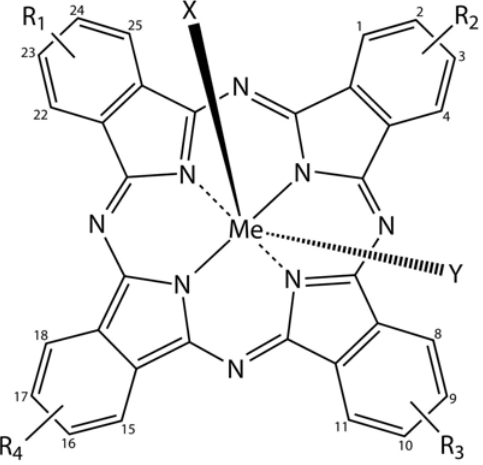
Figure 5. General chemical structure of metal-phthalocyanine dyes. Me denotes the metal ion; R are peripheral functional groups and X and Y are optional functional groups 1-4 above and below the molecule’s plane